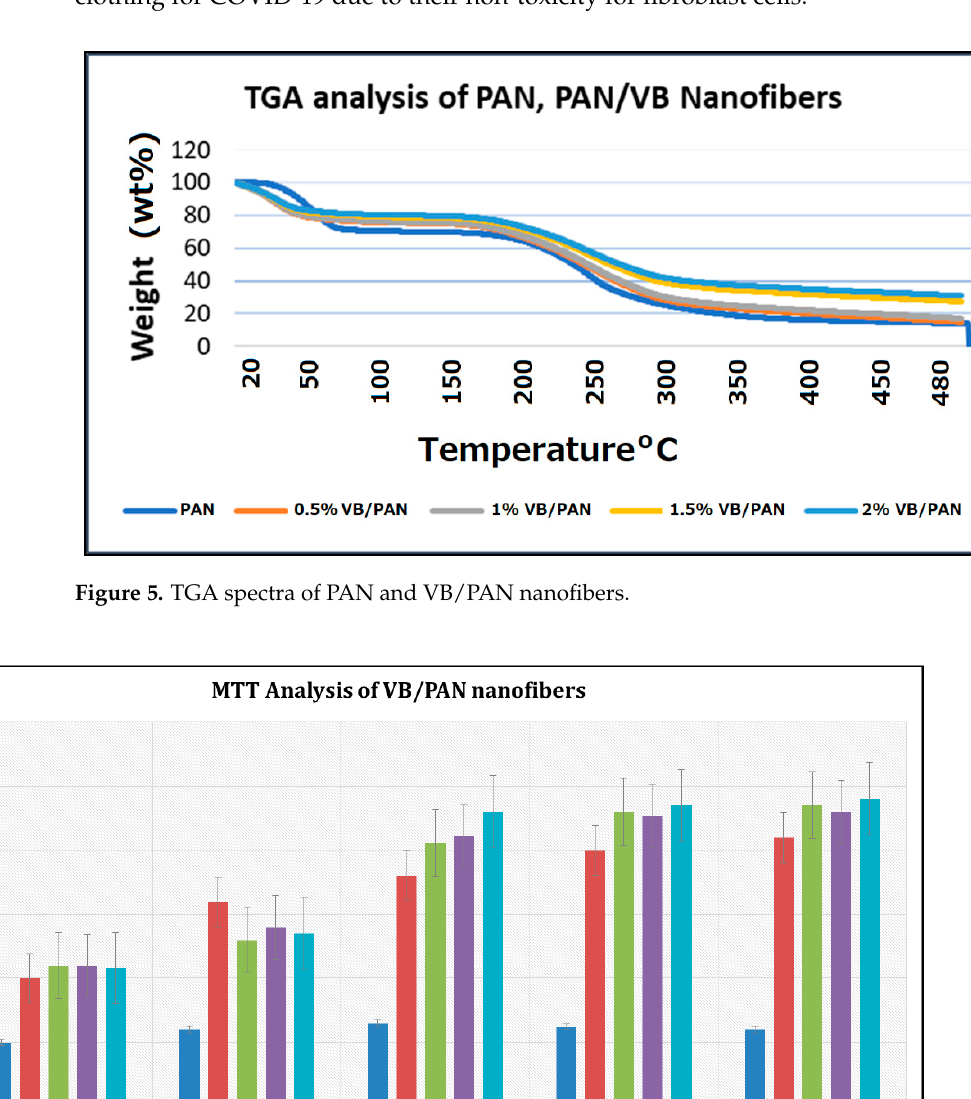
Figure 5. TGA spectra of PAN and VB/PAN nanofibers.